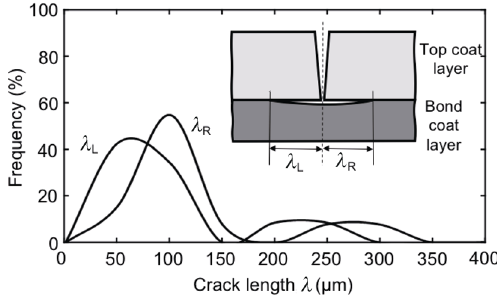
Fig. 8 Distribution of delamination crack length.